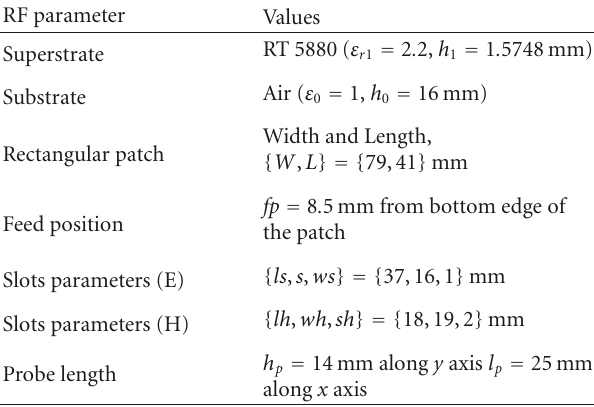
Table 1: The LIEH-shaped MPA design